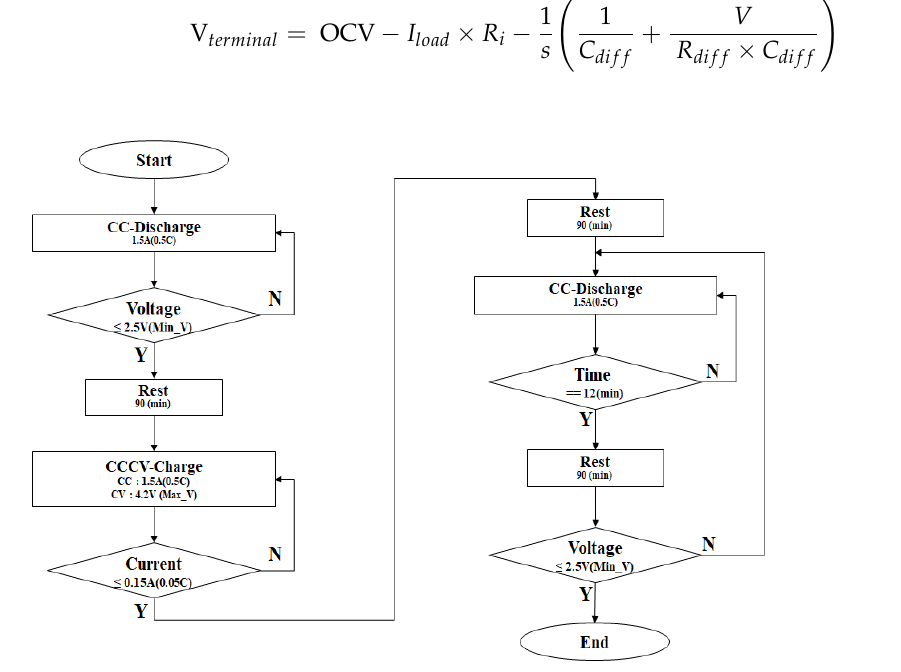
Figure 4. Pulse current discharge test profile.